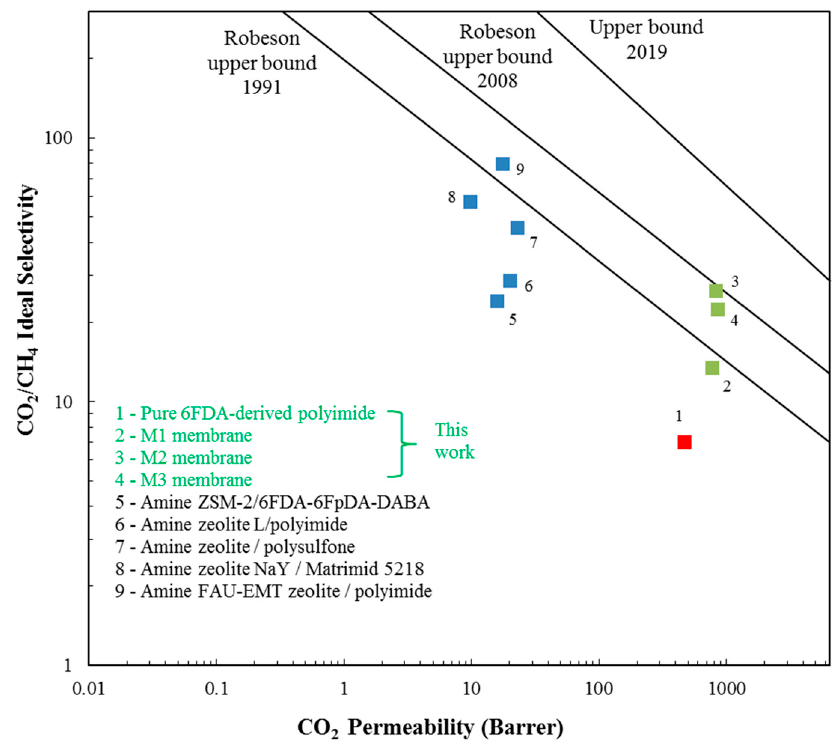
Figure 7. Gas separation performance of membranes fabricated in the present work compared with Robeson’s upper bound.